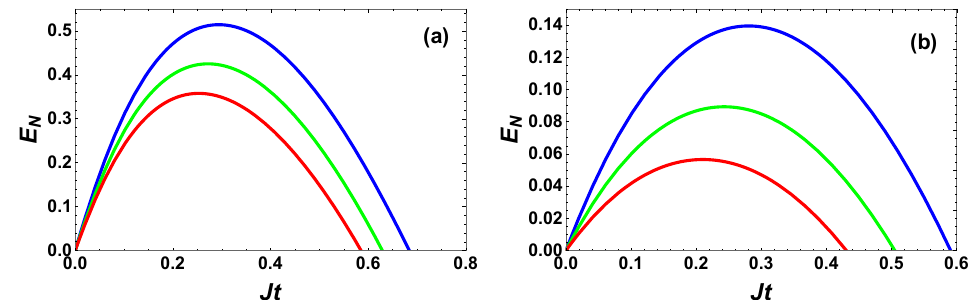
Figure 2. Entanglement generation with coupled gain–loss waveguides without the saturation effect. Panel ( a ) shows the time evolution of the entanglement when the input states are single-mode squeezed vacuum with squeezing parameters r 1 = r 2 = 0.5 and phase factors θ 1 = θ 2 = 0. We choose three different ratios of loss over gain: g = 1.3 γ (red), g = γ (green), and g = 0.7 γ (blue). In ( b ), we assumed that the inputs are squeezed coherent states. Here, α = β = 10exp ( i π /4 ) . The other parameters are like that of the panel ( a ).